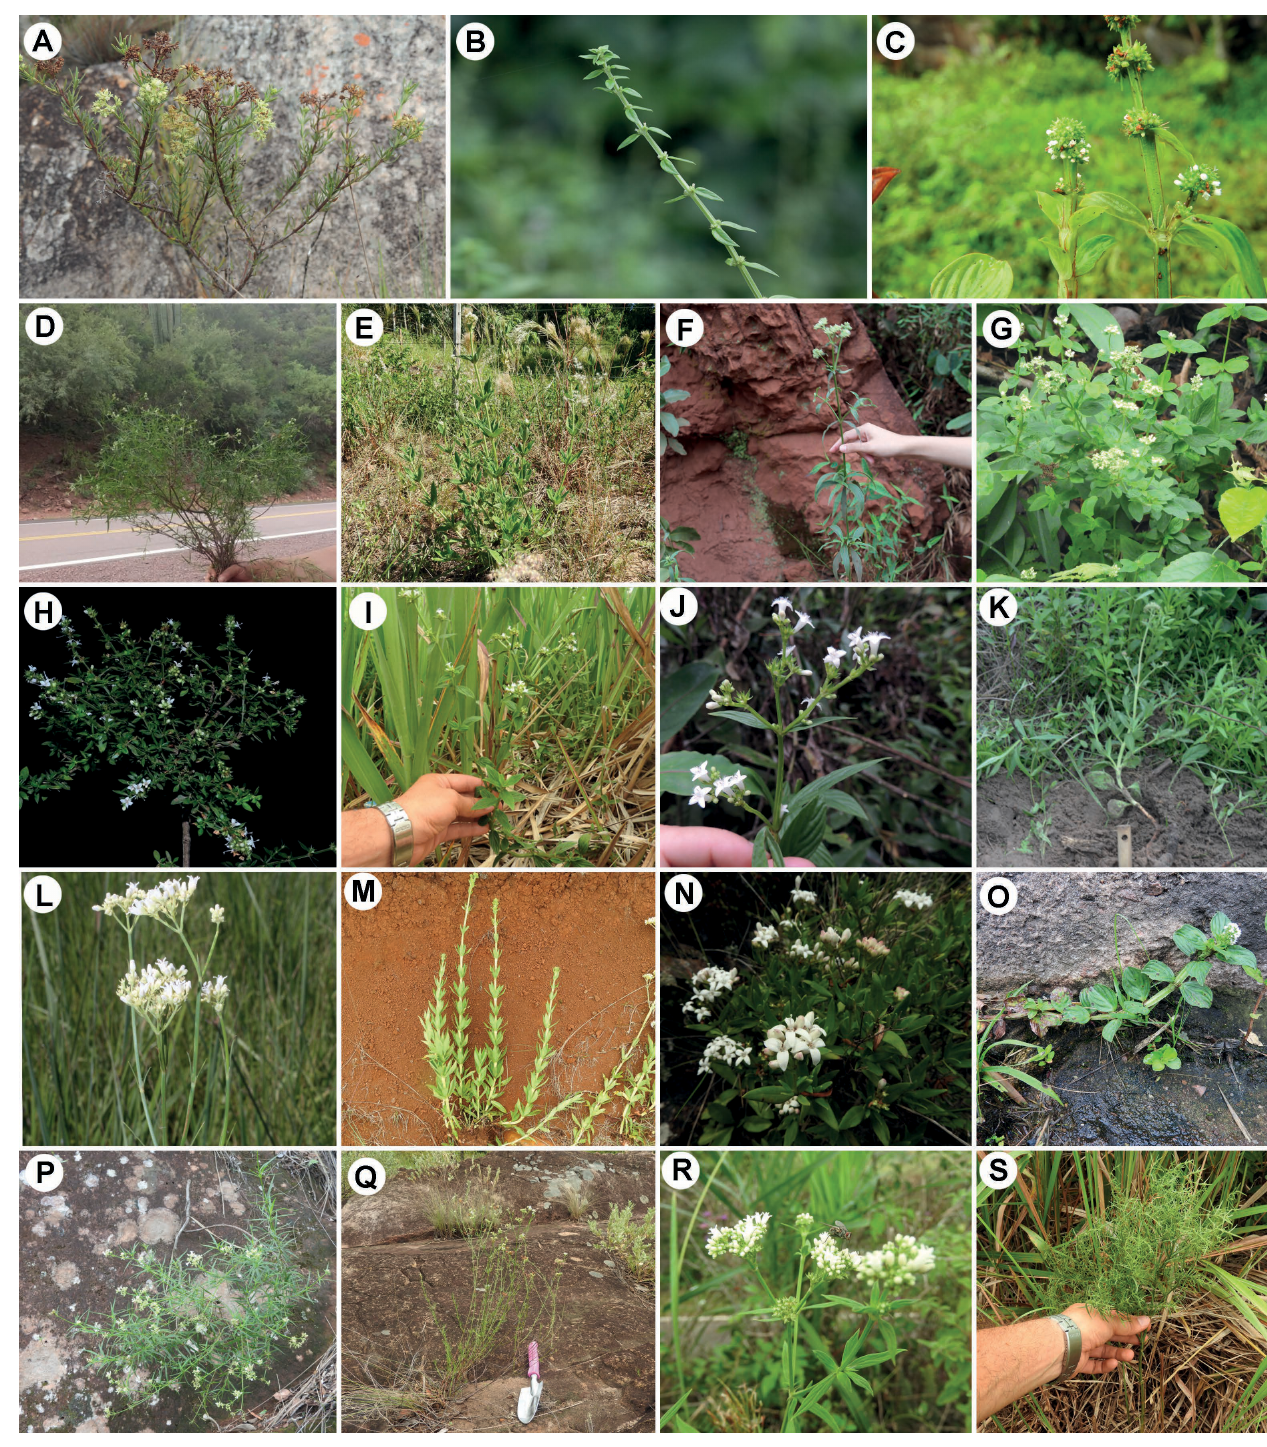
Figure 5 – Species that represent generalized tracks: A–C, Andean tracks; D–G, Brazilian tracks; H–K, Parana tracks; L–O, Pampean tracks; P–O, Chacoan tracks. A, Galianthe peruviana ; B, G. spicata ; C, G. vasquezii ; D, G. bisepala ; E, G. eupatorioides ; F, G. lanceifolia ; G, G. laxa ; H, G. brasiliensis ; I, G. dichasia ; J, G. vaginata ; K, G. centranthoides ; L, G. equisetoides ; M, G. latistipula ; N, G. reitzii ; O, G. palustris ; P, G. aurelii ; Q, G. krausei ; R, G. paraguariensis ; S, G. thalictroides . A–C, portion of a branch; D–S, habit. A, C, E, G, I, K & M–S photographed y J.E. Florentín; B photographed by O. Gaubert; D, H & L photographed by R. Salas; F photographed by F. Pastore; J photographed by J.